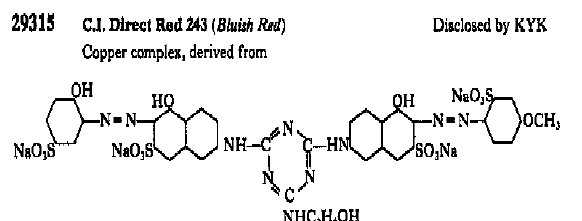
Figure 2: Direct Red BWS (243) (Shams Nateri, Dehnavi et al.